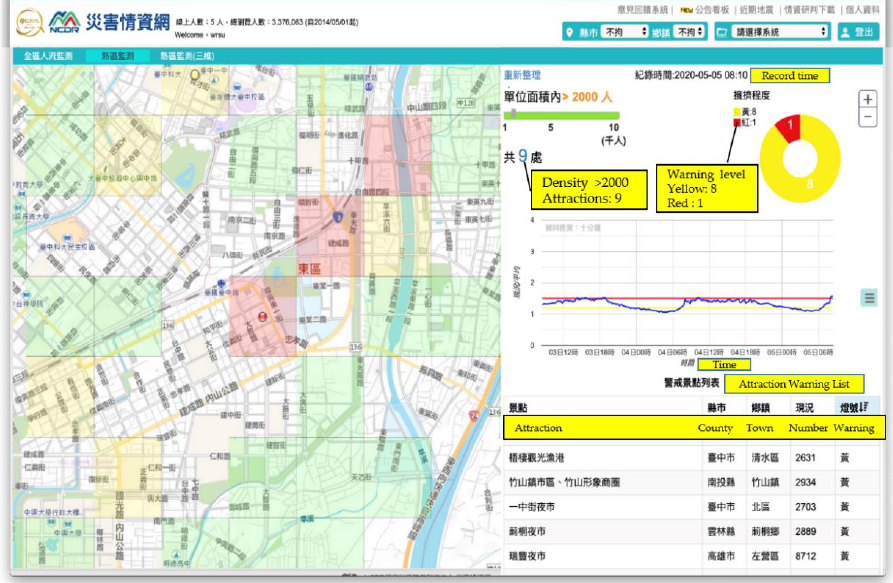
Figure 6. Pandemic intelligence system—dynamic information on crowds and automated alerts.